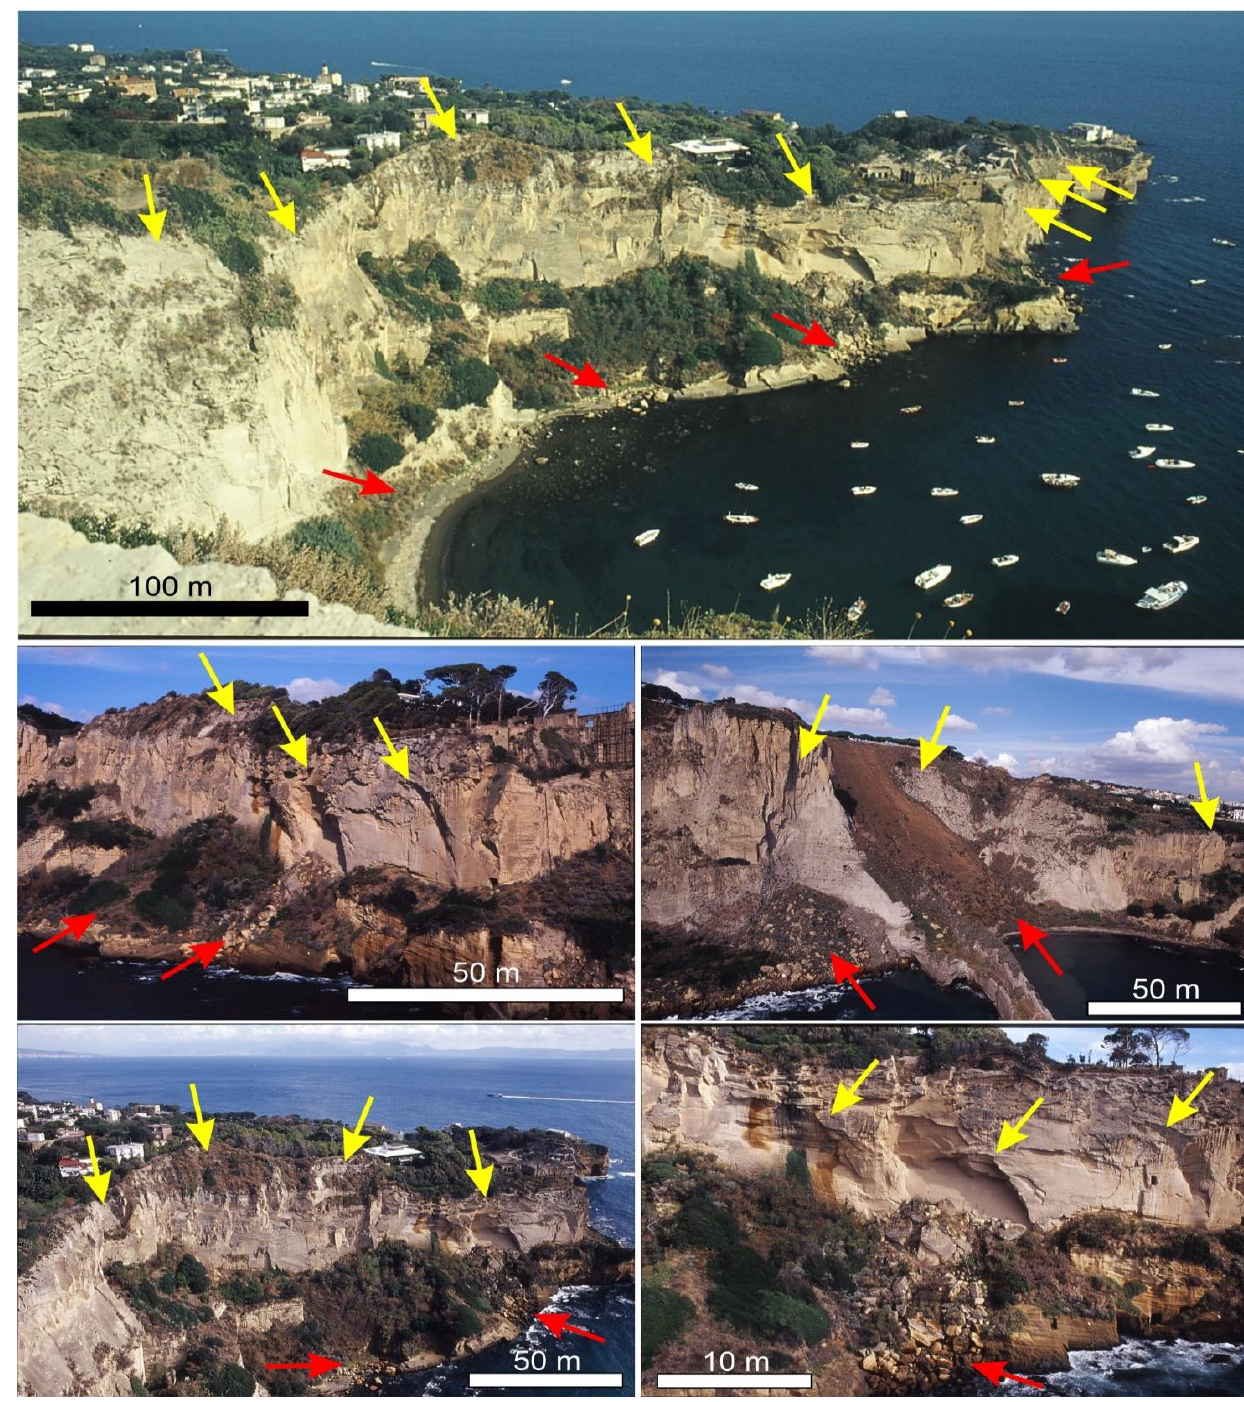
Figure 9. Landsliding along the Coroglio-Trentaremi sea cliff. Red arrows indicate landslide bodies, whereas yellow arrows indicate detachment niches.